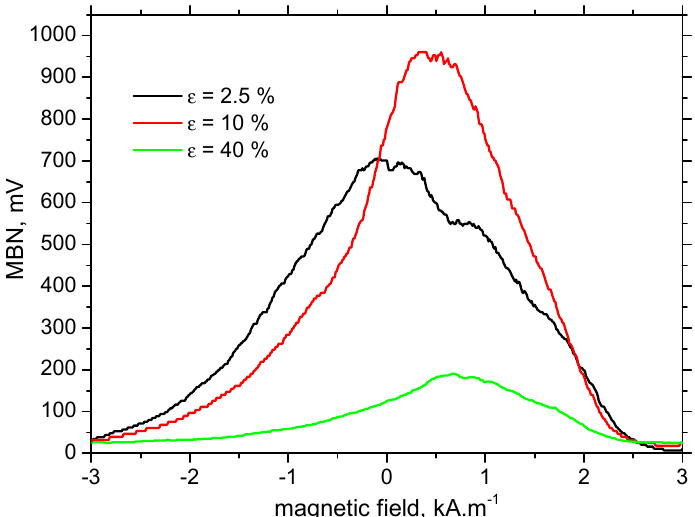
Figure 14. MBN envelopes for the different ε , RD.